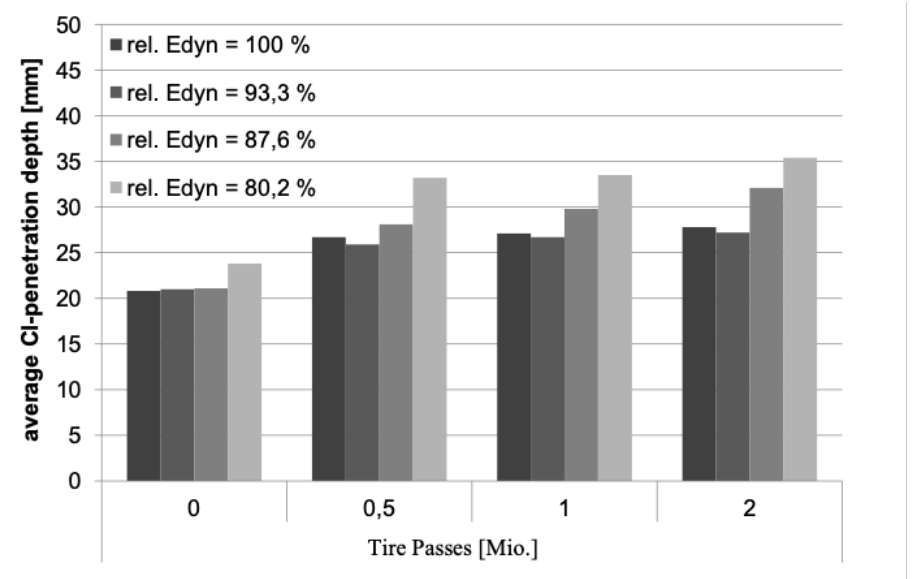
Figure 5. Average chloride penetration depth dependent on the number of tire passes and microstructural